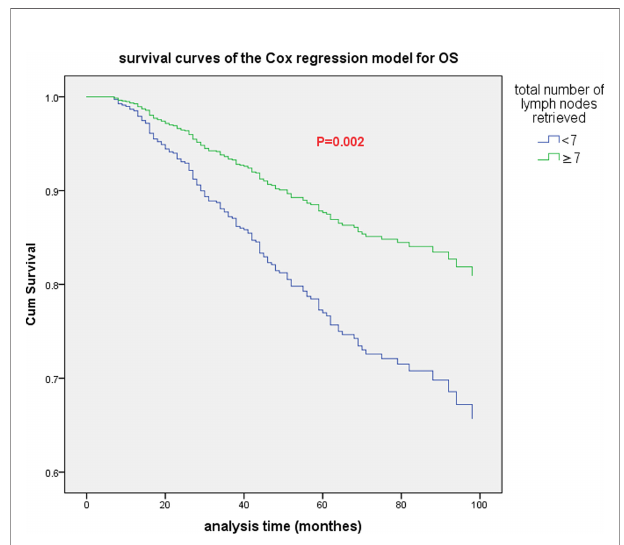
FIGURE 2 | The survival curve (based on multivariate Cox regression) of all patients when the optimal cutoff value of the total number of lymph nodes retrieved was 7.